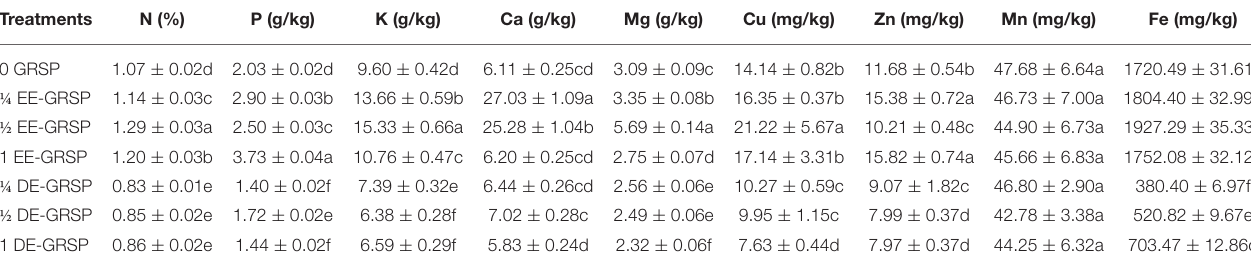
TABLE 3 | Effects of exogenous EE-GRSP and DE-GRSP on nutrient acquisition in roots of trifoliate orange seedlings. Treatments